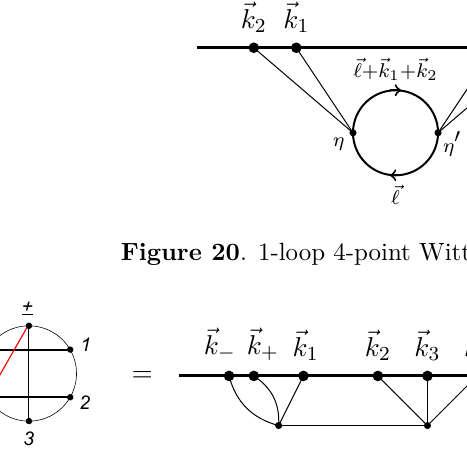
Figure 21 . Perfect matching corresponding to a loop correction to an external